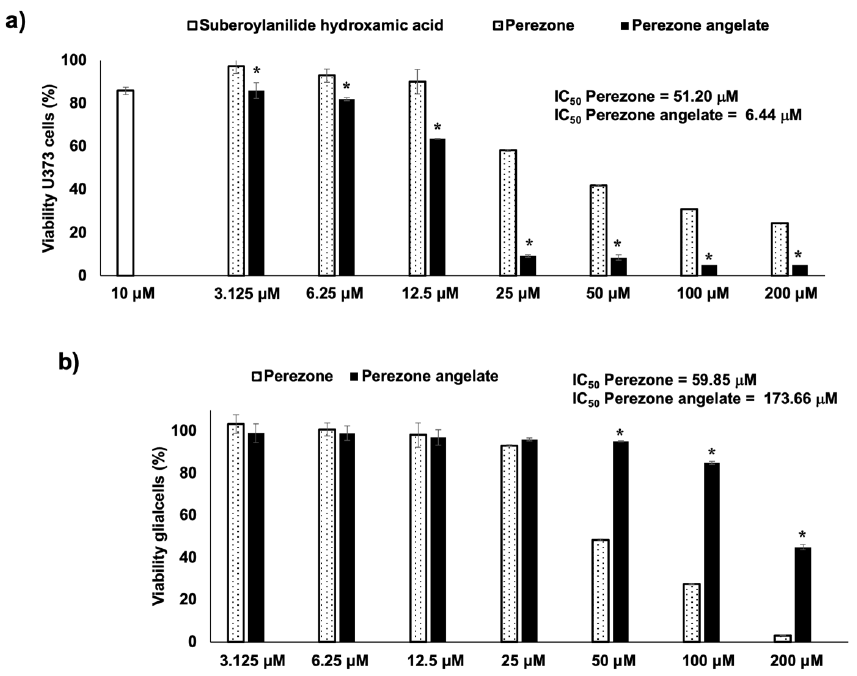
Figure 2. Graph bar of cytotoxic activity of perezone and perezone angelate in the GBM U373 cell line ( a ) and mixed glial cell culture ( b ). U373 cells (5 × 10 4 cells/well) and mixed glial cells (5 × 10 4 cells/well) were incubated without (control) and with crescent concentrations of the studied compounds during 48 h ( n = 8), employing suberoylanilide hydroxamic acid (10 µ M) as a positive control. At the end of the incubation, an MTT assay was performed to determine the viability of cells under treatment. Each bar in the graph indicates percentage means and standard error of the mean, statistical differences were calculated by one-way ANOVA * p < 0.05, (between perezone and perezone angelate at each concentration of tested compounds). Perezone angelate showed higher cytotoxic activity in U373 cells than perezone and lower cytotoxic activity in mixed glial cells than